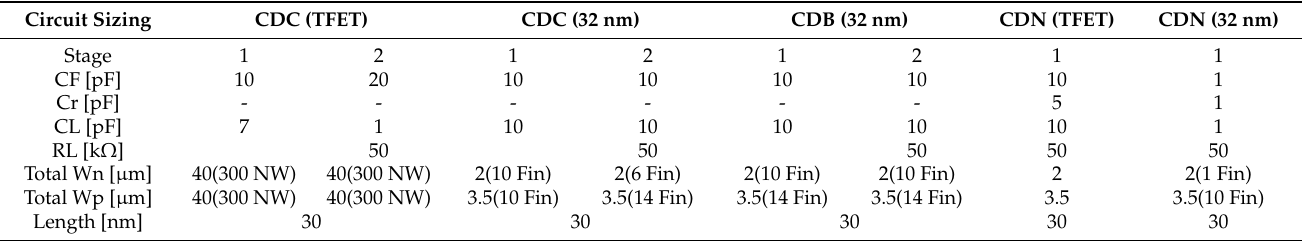
Table 1. Sizing of the two-stage CCDD